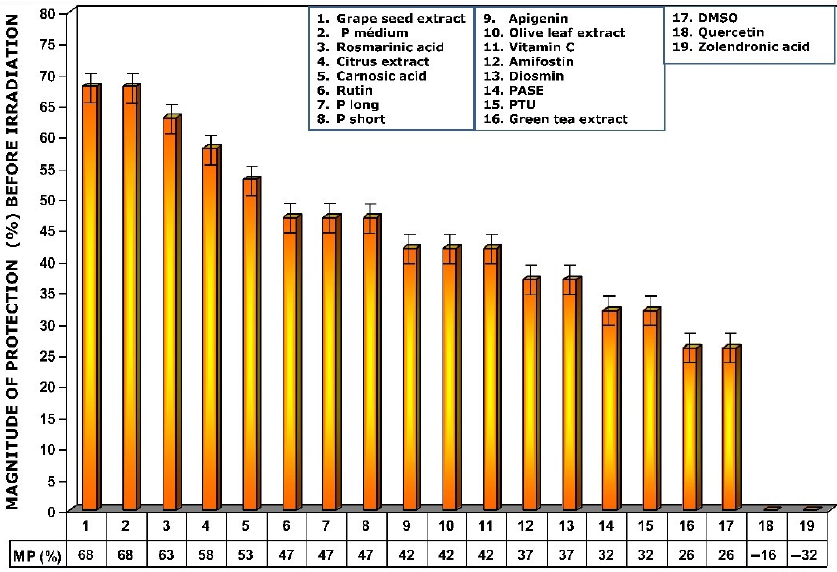
Figure 4. Magnitudes of protection obtained when tested substances were administered immediately before exposure to ionizing radiation.